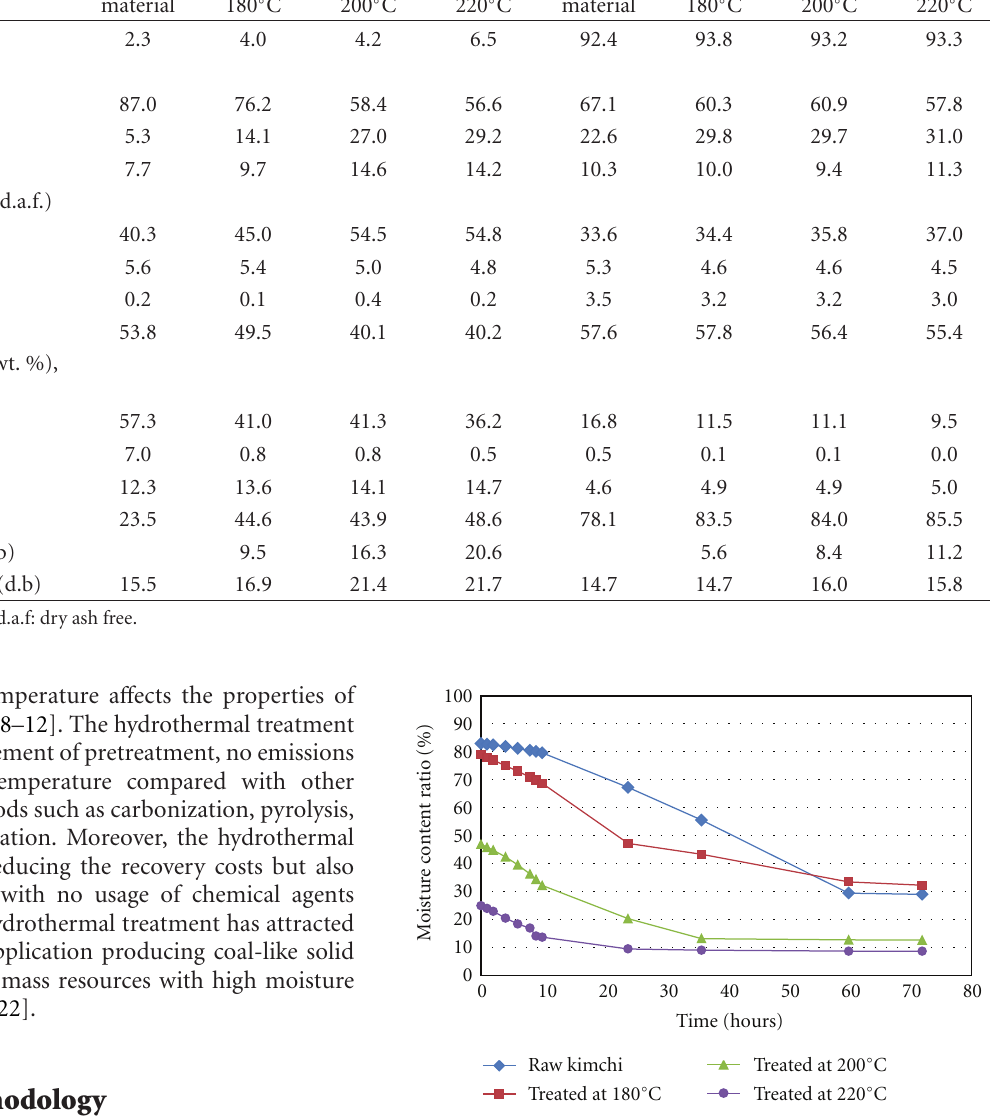
Figure 3: Natural drying performance of raw kimchi and, the dehydrated residue of its hydrothermal